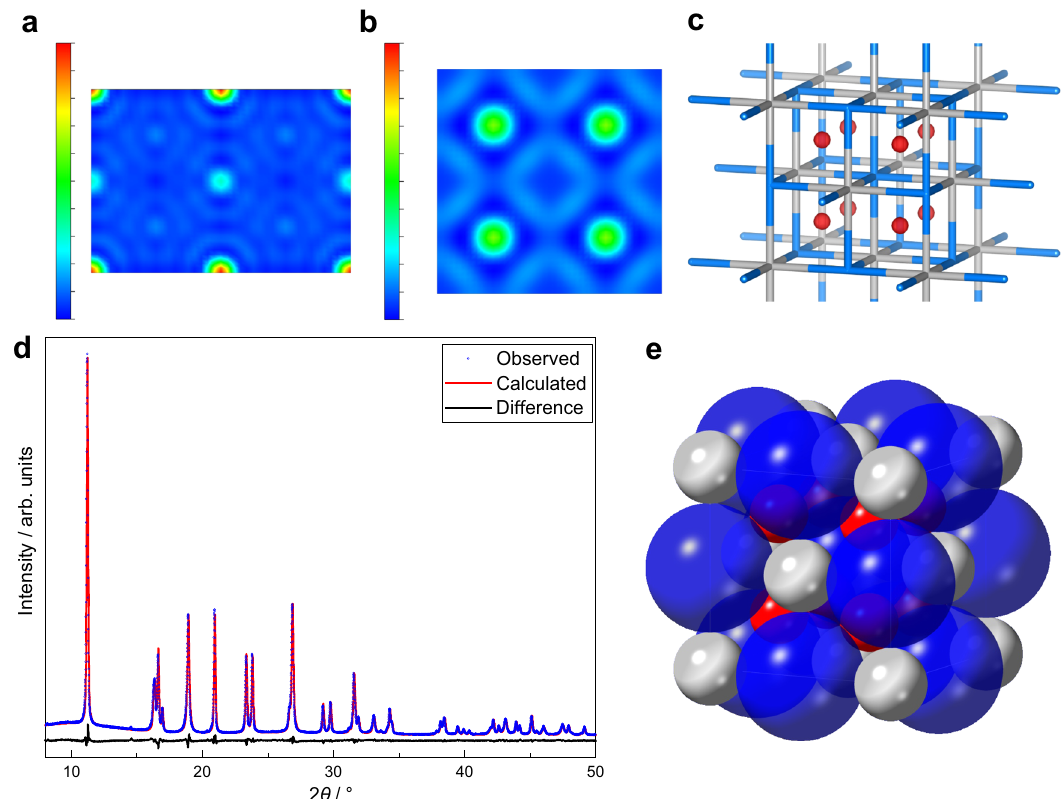
Fig. 7 Phase identi fi cation of TiNO x by Rietveld re fi nement. Electron density maps of the TiNO x unit cell: 2D cross-sections of electron density derived from the Fourier transform of ( a ) F obs at one unit cell length a from the origin along (011); ( b ) F diff ( = F obs − F calc ) at 0.25 a along (001); ( c ) iso-surface of electron density at 0.1 (red); grey: titanium, blue: nitrogen. d Fitting of Rietveld re fi nement of A4 at room temperature consisting of an anatase phase and a titanium oxynitride phase: nitrogen atom is modelled as O 2 − and interstitial oxygen anion modelled as O atom at tetrahedral hole. e Corresponding structure solution for TiNO x : blue: titanium, red: nitrogen, white: